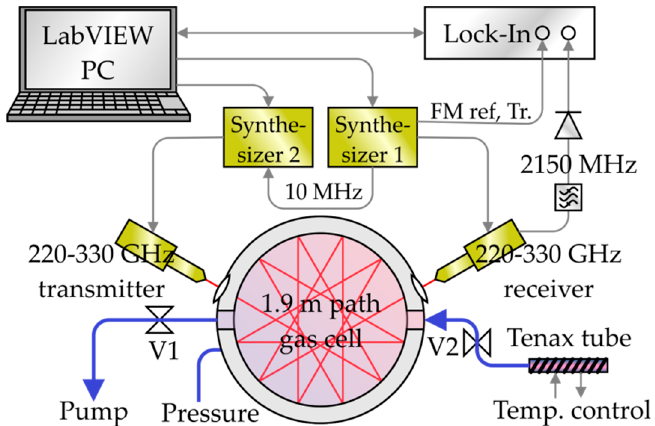
Figure 1. Setup of the mmW/THz gas spectrometer for breath analysis. The volunteer’s breath is released into the gas cell by heating of the Tenax© tube. The desorbed gas is analyzed by second harmonic (2f)-spectroscopy in the frequency range from 220 to 330 GHz.